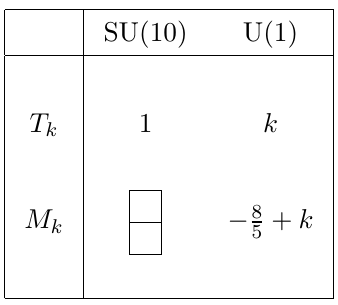
Table 2 . Matter content in IR (below con(cid:12)nement scale (cid:3)).